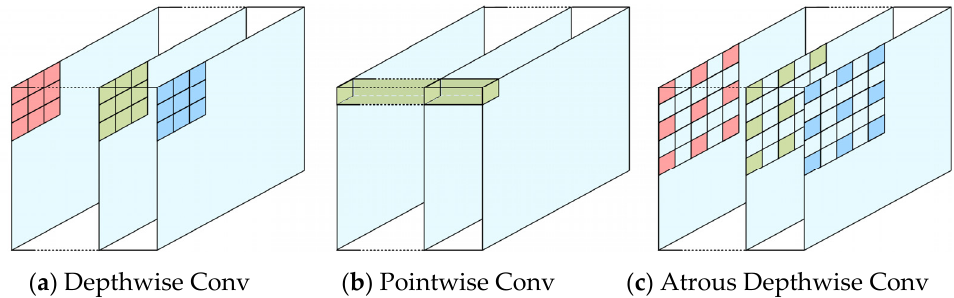
Figure 4. ( a ) 3 × 3 depth convolution is spatial convolution on each channel alone; ( b ) point-by-point convolution is a combination of depth convolution using 1 × 1 convolution kernels to obtain features; ( c ) 3 × 3 Atrous Separable Convolution with rate of 2 is a combination of Atrous Convolution and depth convolution to increase the perceptual field of the convolution.